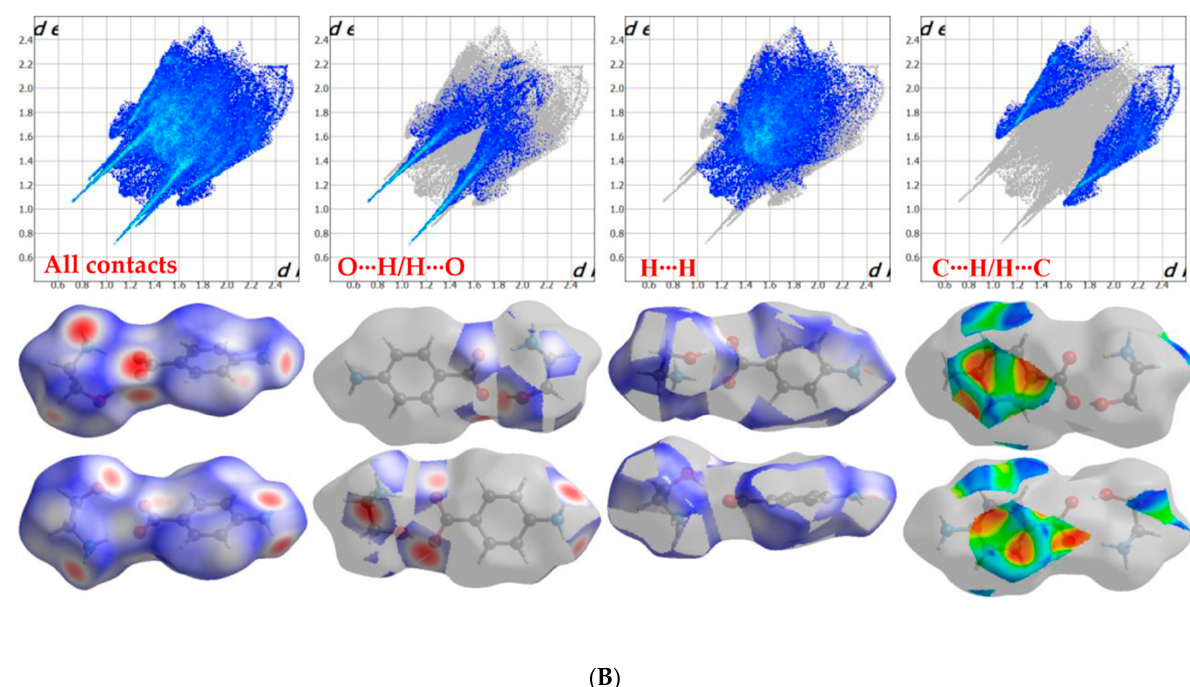
Figure 3. 2D fingerprint plots (up) and Hirshfeld surfaces (down) of the different interactions (for all contacts, O∙∙∙H/H∙∙∙O, H∙∙∙H and C∙∙∙H/H∙∙∙C) in both compounds, HEA- p NBA ( A ) and HEA- p ABA ( B ), in two orientations. The next share of entire surface is related to C ··· H/H ··· C contacts (6.6% in HEA- p NBA and 22.5% in HEA- p ABA) that are observed as two partially wide wing-like peaks and usually represent C-H ··· π interactions. These contacts prevail in HEA- p ABA more than 3 times than in the HEA- p NBA structure, while in the last one are observed C ··· C contacts (5.1%) attributed to π ··· π interactions, which do not appear in HEA- p ABA. The inspection of C ··· C interactions in HEA- p NBA shows a clear signature on the 2D fingerprint plot (Figure 4), which contains a green/blue triangle region (bow-tie pattern) or can be observed as red and blue triangles on the shape-index surface.